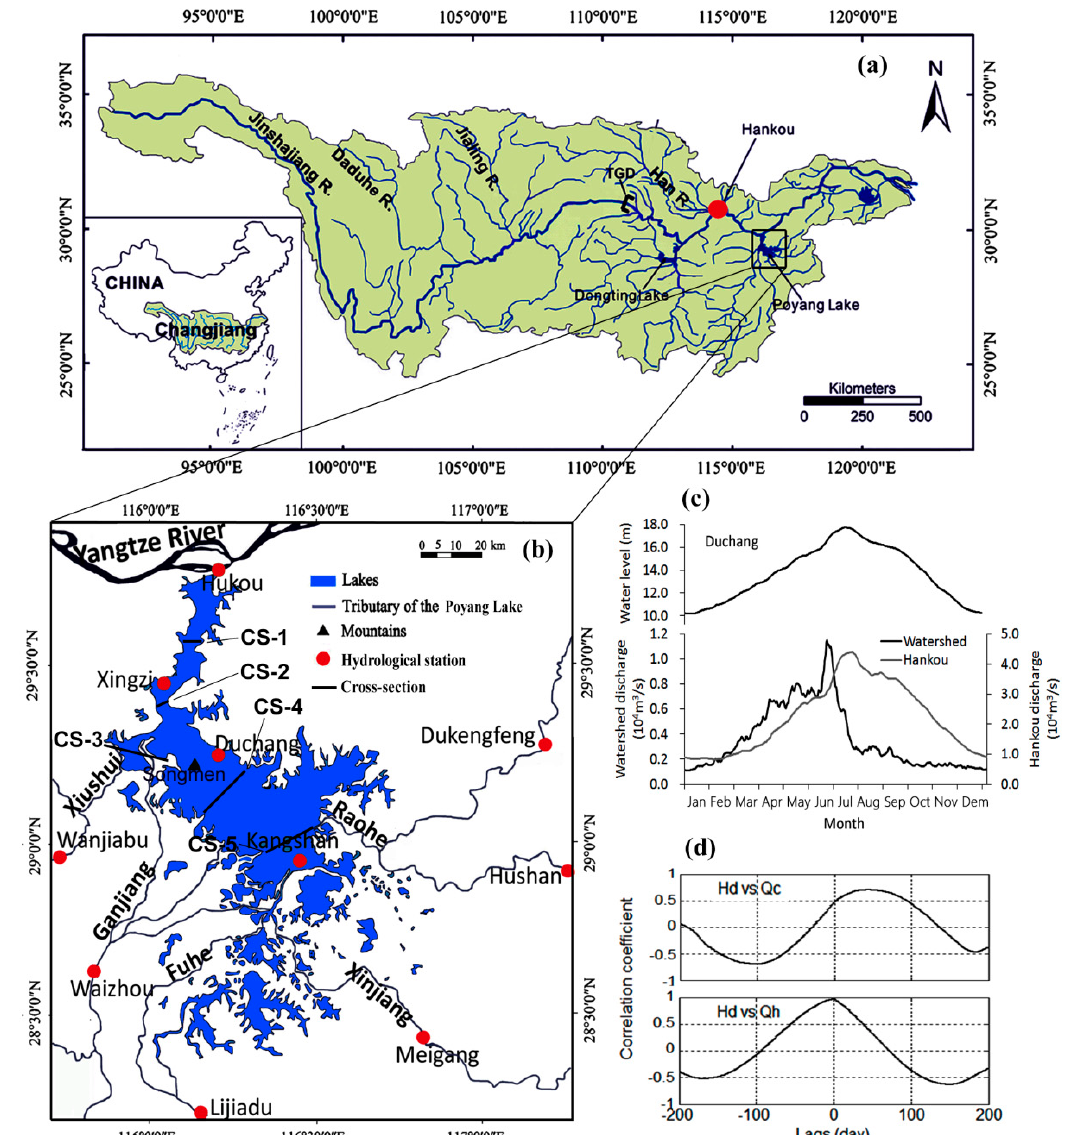
Figure 1. ( a ) Location of Poyang Lake; ( b ) Poyang Lake and its main inflow rivers with hydrological gauging marked; ( c ) intra-annual variation of catchment inflow, Yangtze flow (Hankou) and corresponding lake water level; ( d ) cross-correlation coefficients between lake water level (Hd—lake water level at Duchang station) and catchment inflow (Qc) as well as Yangtze flow (Qh—river discharge at Hankou station), respectively.